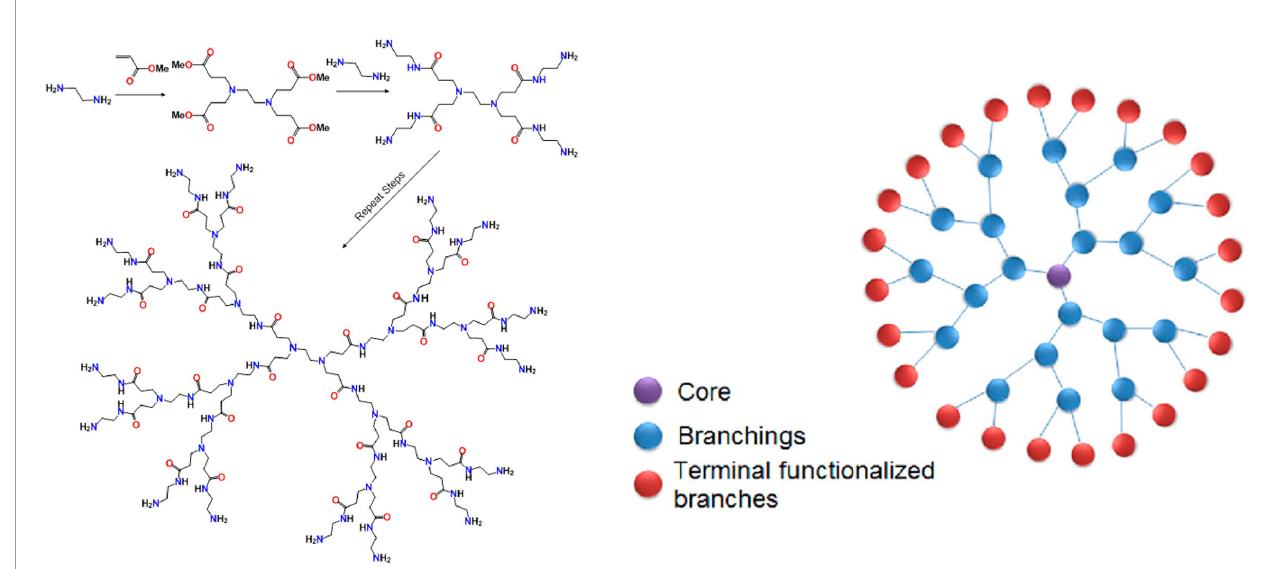
FIGURE 7 | Basic synthetic scheme for construction of a PAMAM dendrimer (left). Schematic representation of a 24-mer dendritic